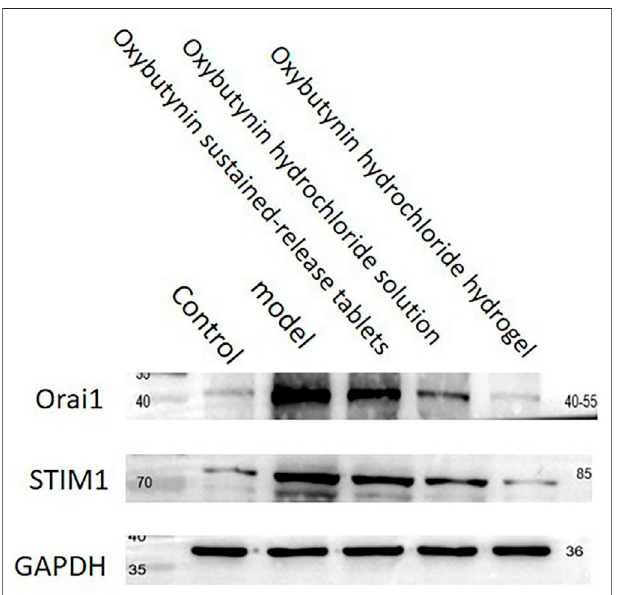
FIGURE 7 | Relative expression of oral mRNA and STIM1